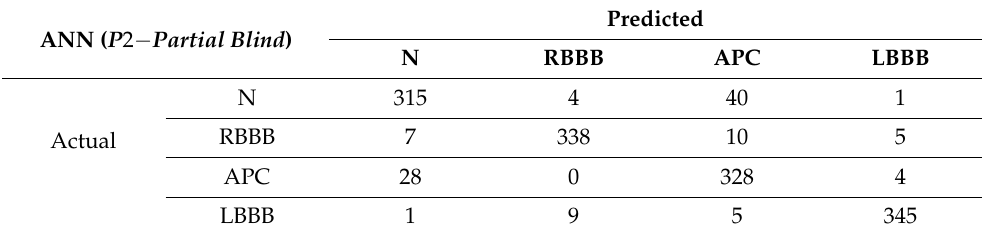
Table 8. Confusion matrix for the ANN classifier applied to the P 2 dataset within the partial blind testing protocol (accuracy =